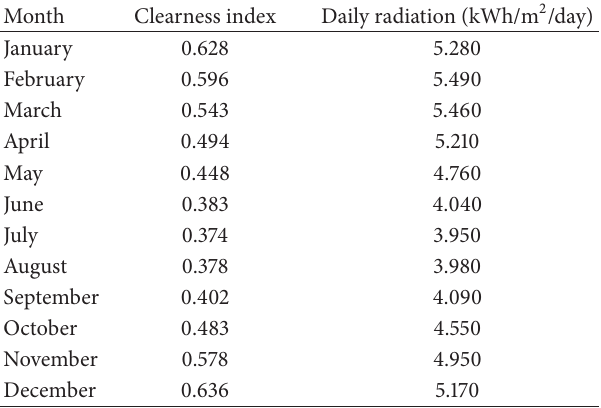
Table 3: Daily averaged solar incident on a horizontal surface.